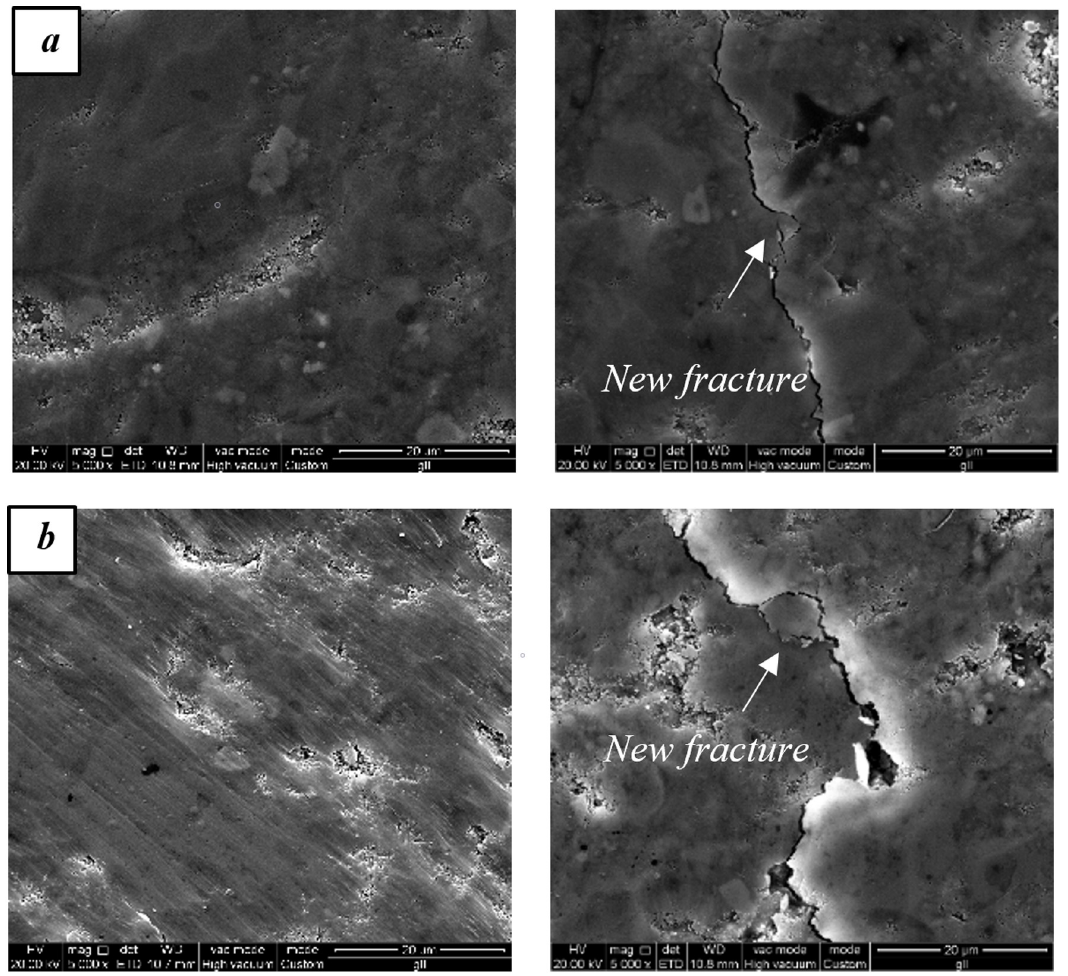
Fig 10. The SEM images showing the morphology and generated micro-fractures obtained before and after 5 min of electromagnetic